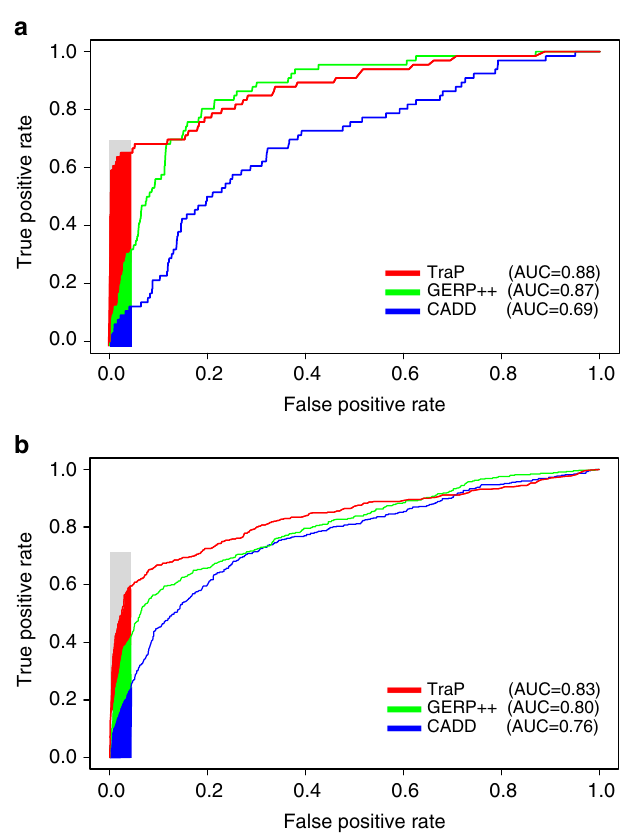
Fig. 3 ROC curves of ClinVar pathogenic and benign variants. a A ROC curve of ClinVar pathogenic and benign synonymous variants, calculated for TraP ( red ), GERP++ ( green ) and CADD (blue). b Same as a but for ClinVar intronic variants. Colored area represents high speci fi city